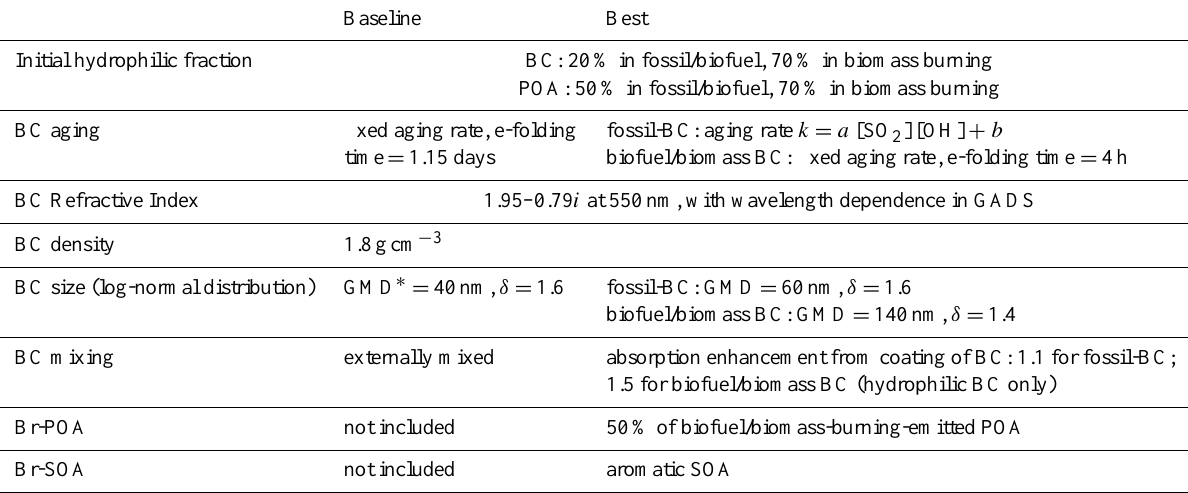
Table 1. Summary of parameterizations for carbonaceous aerosols in the “baseline” and “best” configurations in